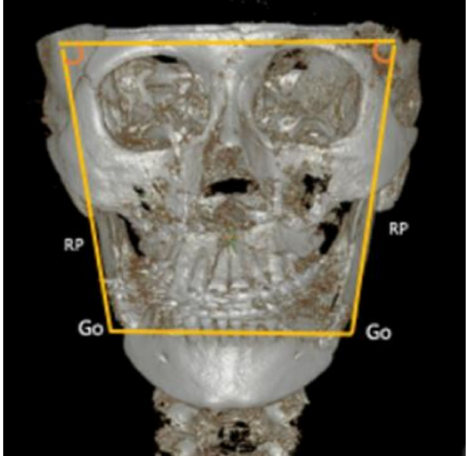
Figure 3. Total angle: angle of